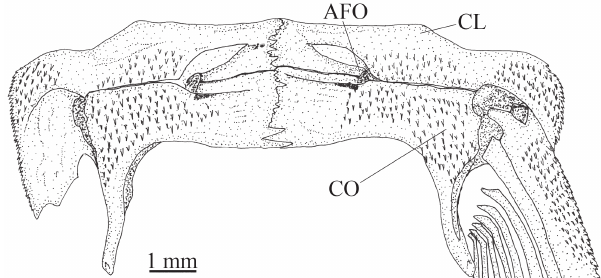
Fig. 6. Ventral view of pectoral girdle of Parotocinclus spilurus , UFRN 0321, 34.9 mm SL, female . Abbreviations: AFO, arrector fossa opening; CL, cleithrum; CO,